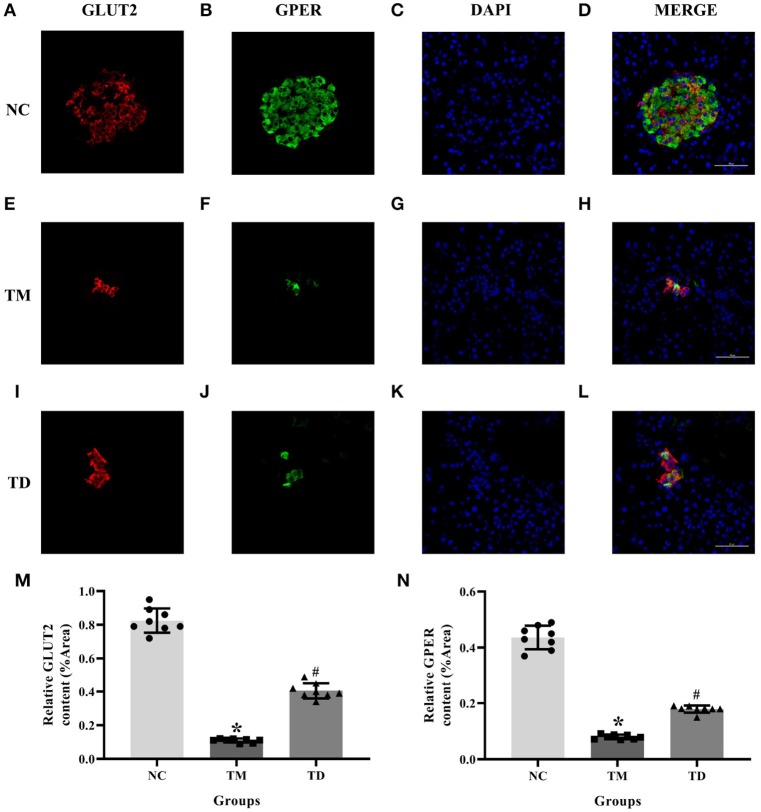
Immunolocalization of GPER and GLUT2 in rat islet tissues. (A–D) NC group, (E–H) TM group, and (I–L) TD group. (M,N) Relative GLUT2 and GPER content. Immunofluorescence double staining confocal of rat islet β cells for GPER (green), GLUT2 (red). Nuclei were stained with DAPI (blue) and merged images. Scale bars: 50 μm. GPER, G protein-coupled estrogen receptor; GLUT2, Glucose transporter 2; DAPI, 4′, 6-diamidino-2-phenylindole; NC, the normal control group; TM, the type 2 diabetes mellitus group; TD, the type 2 diabetes mellitus drug-treatment group. n = 8 rats in each group. Results of one-way ANOVA demonstrated *P < 0.05 compared to the NC group. #P < 0.05 compared to the TM group. Data were presented as the mean ± standard deviation.